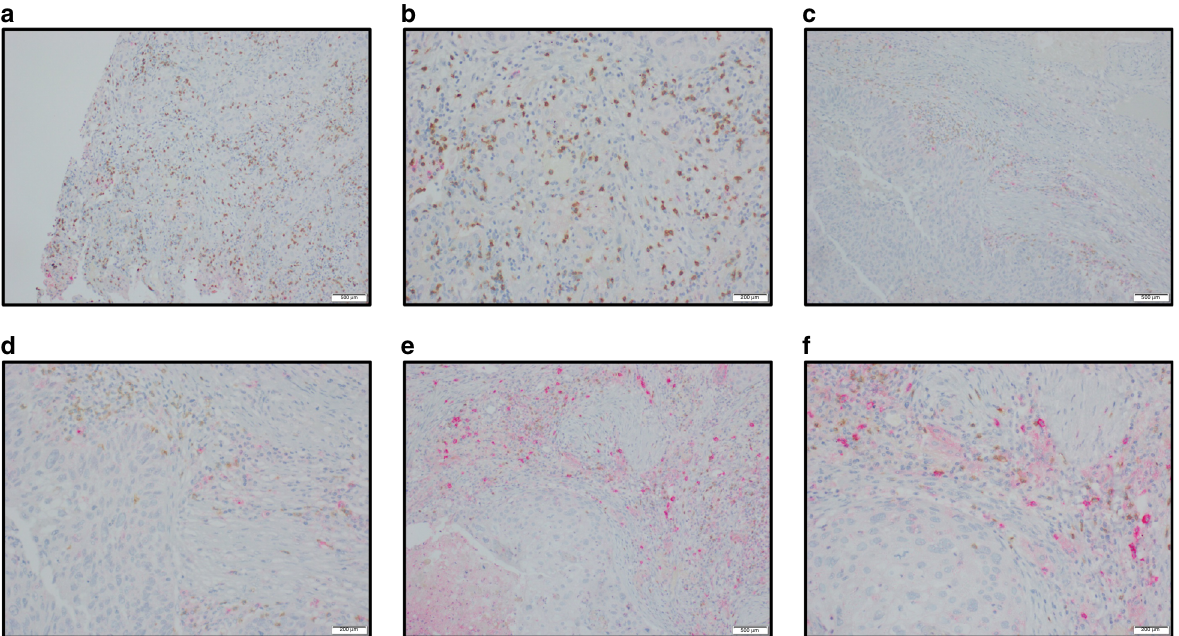
Fig. 3 Scoring intratumoral and stromal myeloid lineage cells in In fl amed A and B. The IHC for case 1 at low ( a ) and high power magni fi cation ( b ) highlights minimal CD33 + stromal neutrophils (in red) with a score of 1 + while background CD8 + stromal lymphocytes are highlighted in brown. The IHC for case 2 at low ( c ) and high power magni fi cation ( d ) highlights a moderate CD33 + neutrophil population within the stroma with a score of 2 + with rare intratumoral CD33 + neutrophils. The IHC for case 3 at low ( e) and high power magni fi cation ( f) illustrates the marked CD33 + neutrophil population within the stroma with a score of 3 + . Scoring legend: 0 = virtual absence, 1 = low (<25%), 2 = moderate (25 – 50%), and 3 = marked increase (>50%)